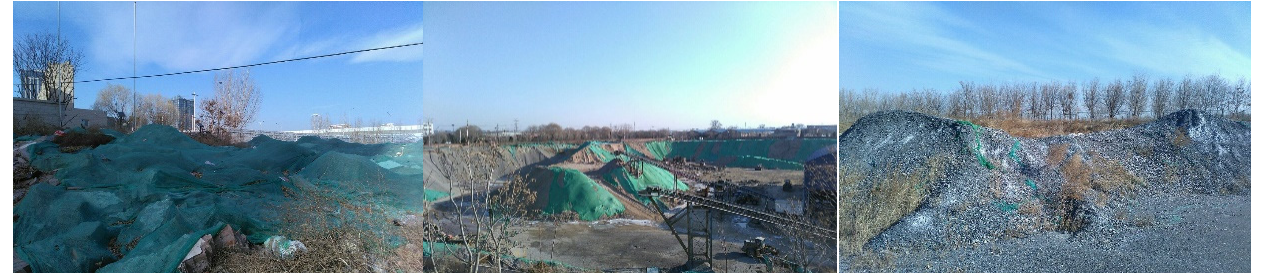
Figure 8. Field investigation of C&DW in Beijing on 15 December 2020.